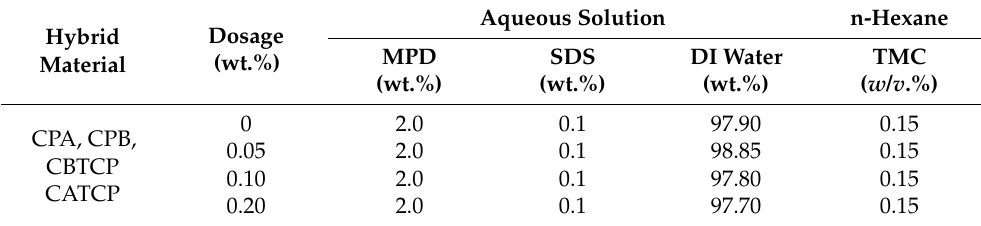
Aqueous Solution n-Hexane